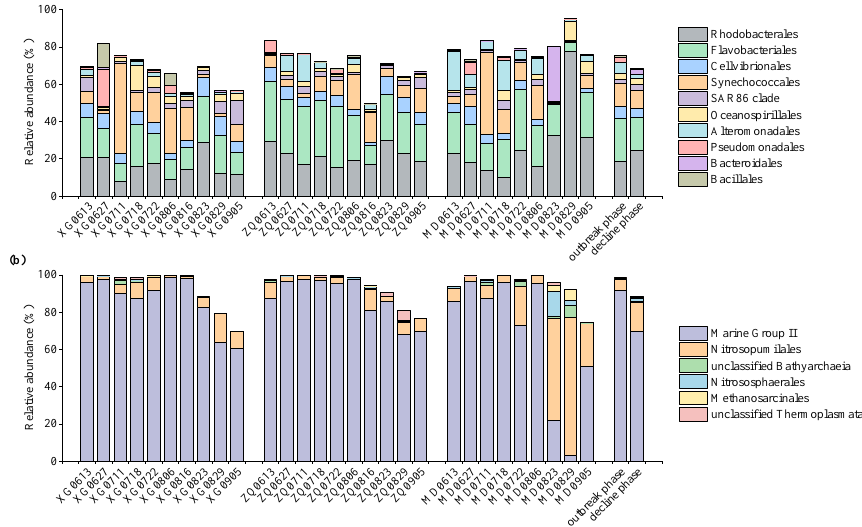
Figure 2. Relative abundance of dominant bacterial ( a ) and archaeal ( b ) taxa at the order level during the green tide.